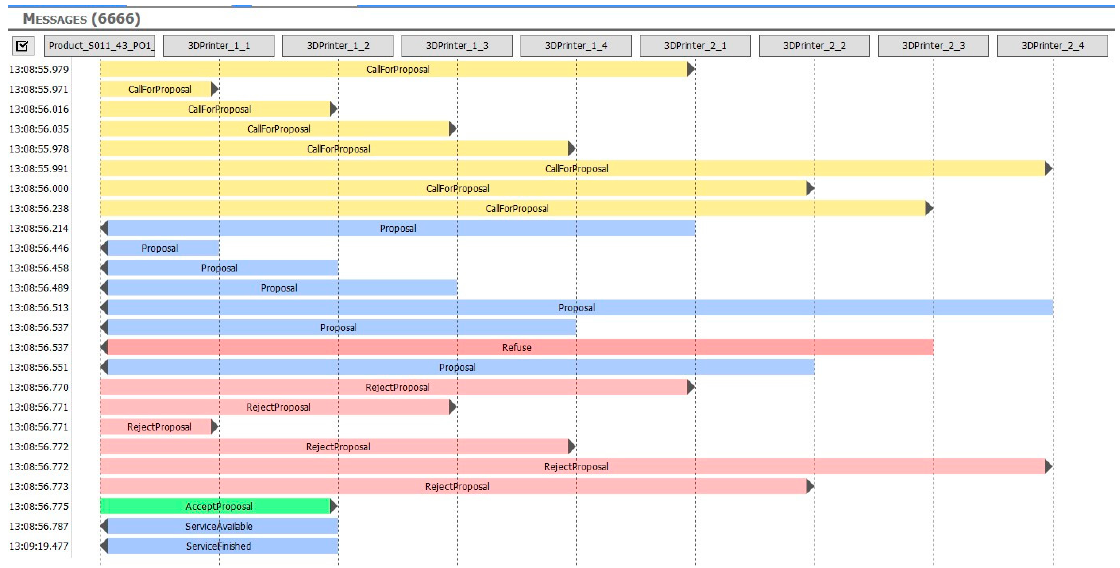
Figure 15. The bidding between a product and multiple printers.